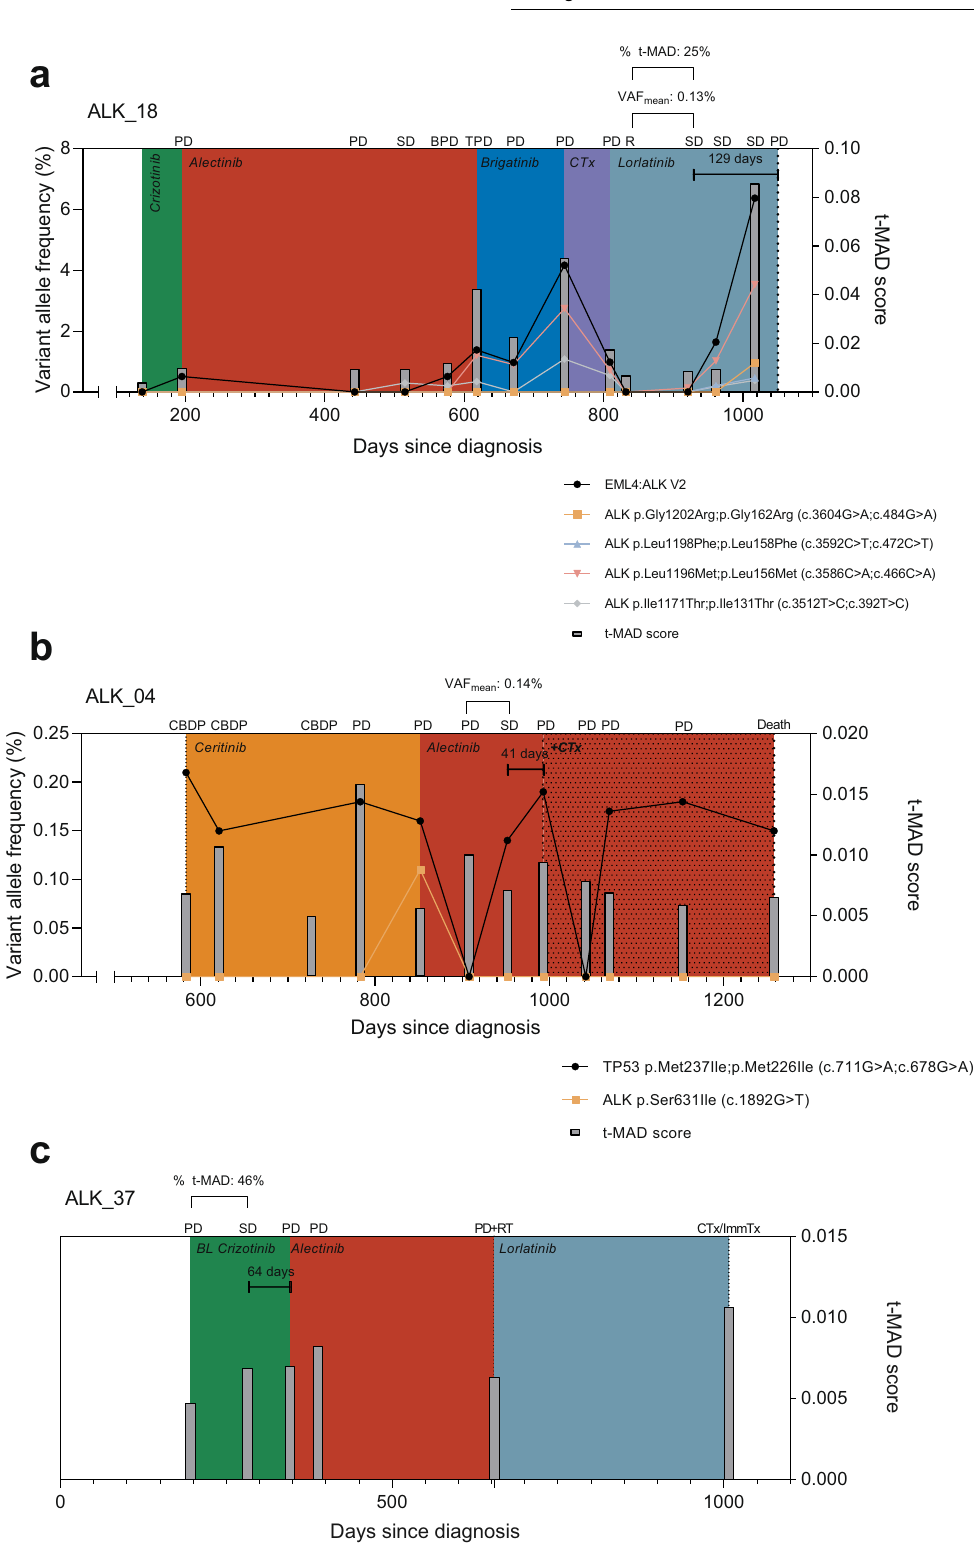
Fig. 4 Representative cases illustrating early molecular progression as indicated by elevated Δ VAF mean and % Δ t-MAD. a Patient ALK_18 presented a case — during lorlatinib therapy — where both Δ VAF mean and % Δ t-MAD were informative of the lead time. Early molecular progression was apparent 129 days prior to clinical progression, as indicated by Δ VAF mean of 0.13% and % Δ t-MAD of 25%. Both values surpass the NGS metric thresholds identi fi ed in this study. b Patient ALK_04 depicts a case wherein Δ VAF mean indicated early molecular progression during alectinib therapy. A Δ VAF mean of 0.14% was calculated 41 days prior to clinical progression. c Patient ALK_37 emphasizes the relevance of untargeted NGS in ctDNA monitoring particularly in cases where genetic alterations remained undetected by tNGS. Here, % Δ t-MAD of 46% was already apparent at a stable disease time point, 64 days prior to clinical progression. PD progressive disease, SD stable disease, BPD brain PD, TPD thoracic PD, R response, CBDP treatment continuation beyond disease progression, RT radiotherapy, CTx chemotherapy, ImmTx